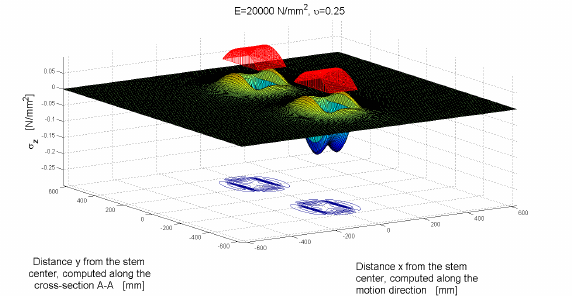
Figure 34: 3-D surfaces and stress contours of near the surface for the interaction model of Figure 32 (second order